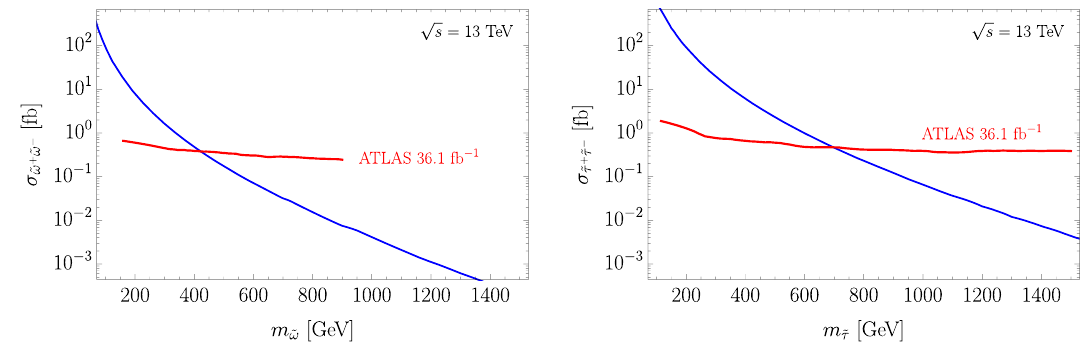
Figure 3 . Upper 95% CL limits on the cross section for DY pair-production of j Q j = 1 heavy stable scalars (left) and fermions (right) from an ATLAS search in 36 : 1 fb (cid:0) 1 of data at (red). The theoretical predictions for the twin pNGB ~ ! (cid:6) and the twin tau ~ (cid:28) are also shown